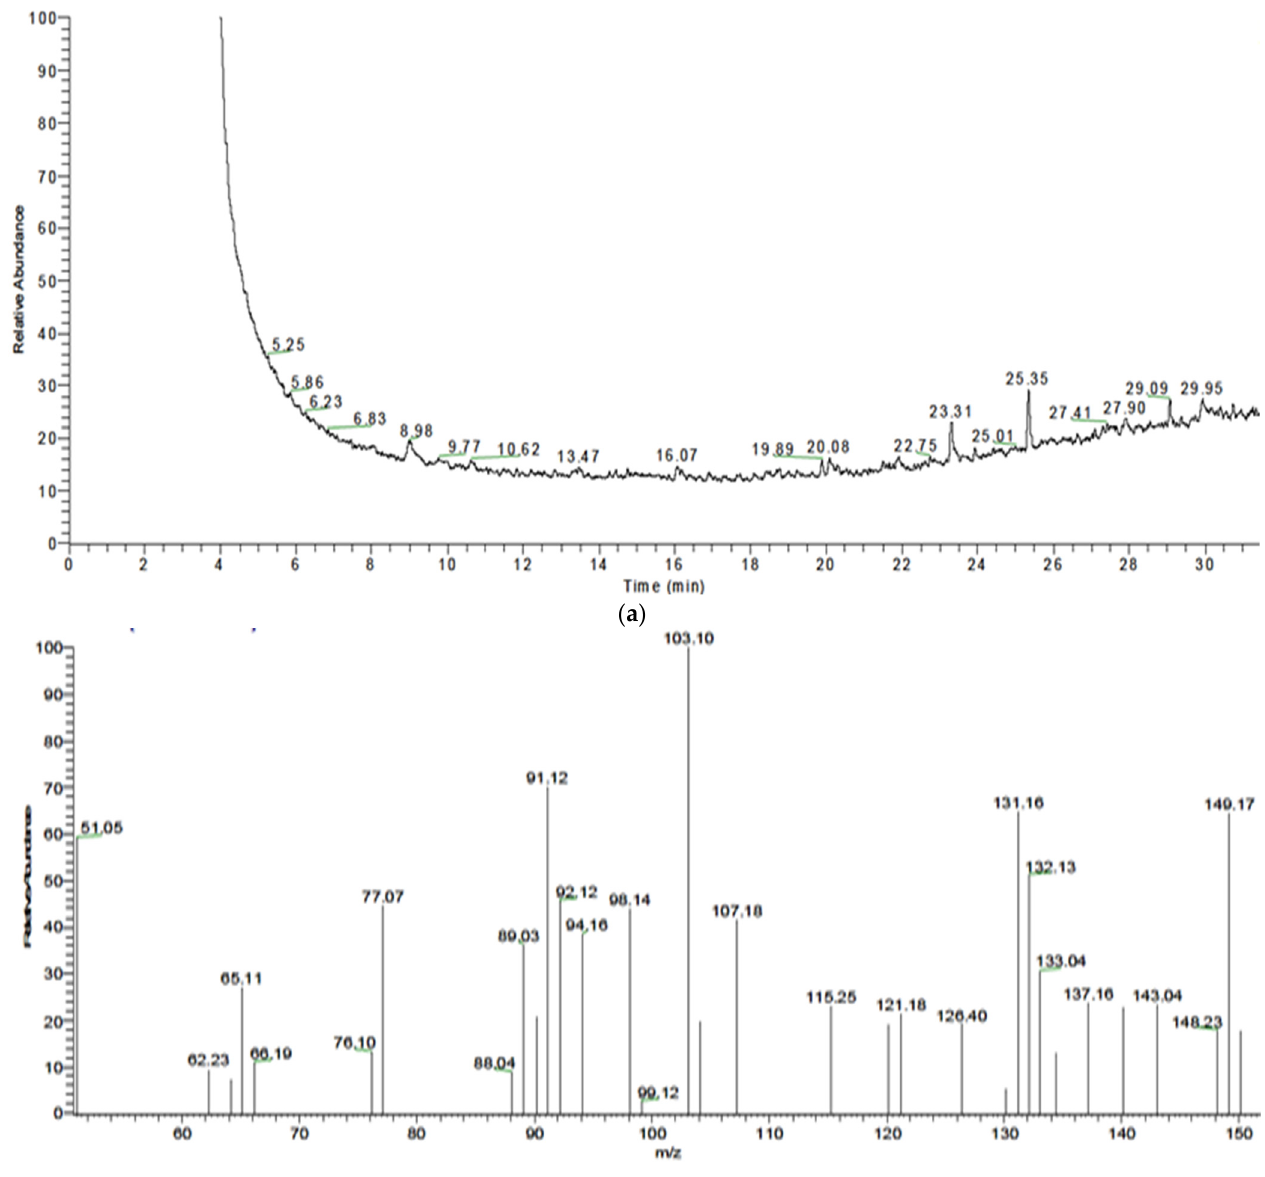
Figure 5. ( a ): Total GC-MS chromatogram of PHB extracted from Brevundimonas naejangsanensis. ( b ): The mass spectrum of isopropyl ester of 2-butenoic acid of PHB extracted from Brevundimonas naejangsanensis.